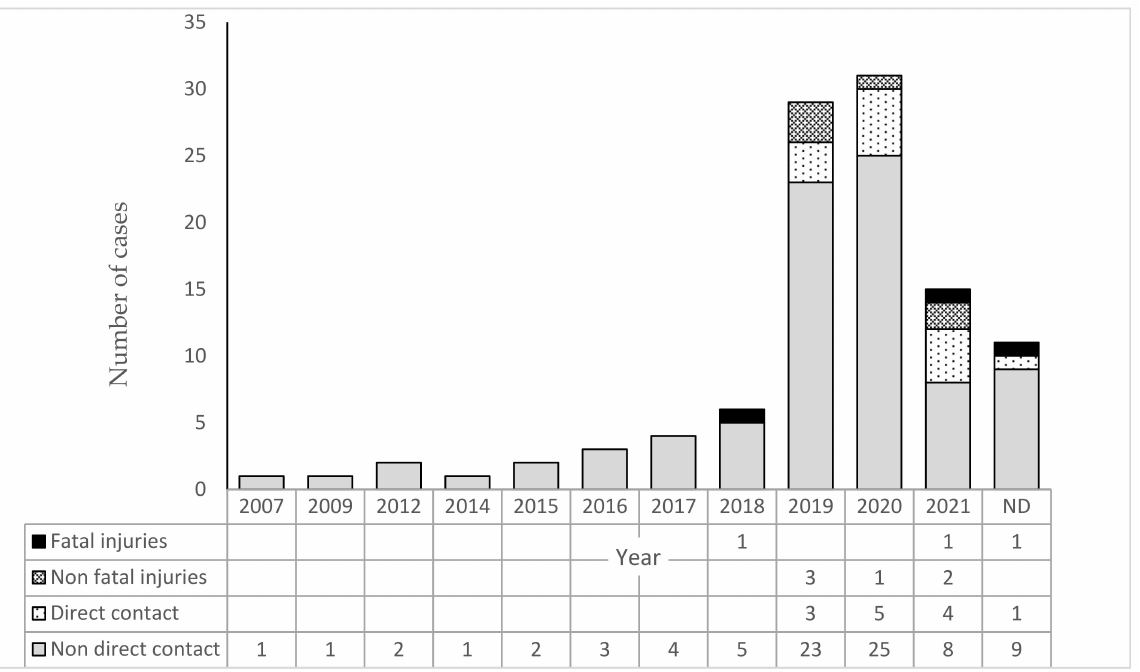
Figure 1. Number of wolves observed during outdoor activities with dogs and the number of observations that ended in direct wolf–dog contact, including those with fatal and non-fatal